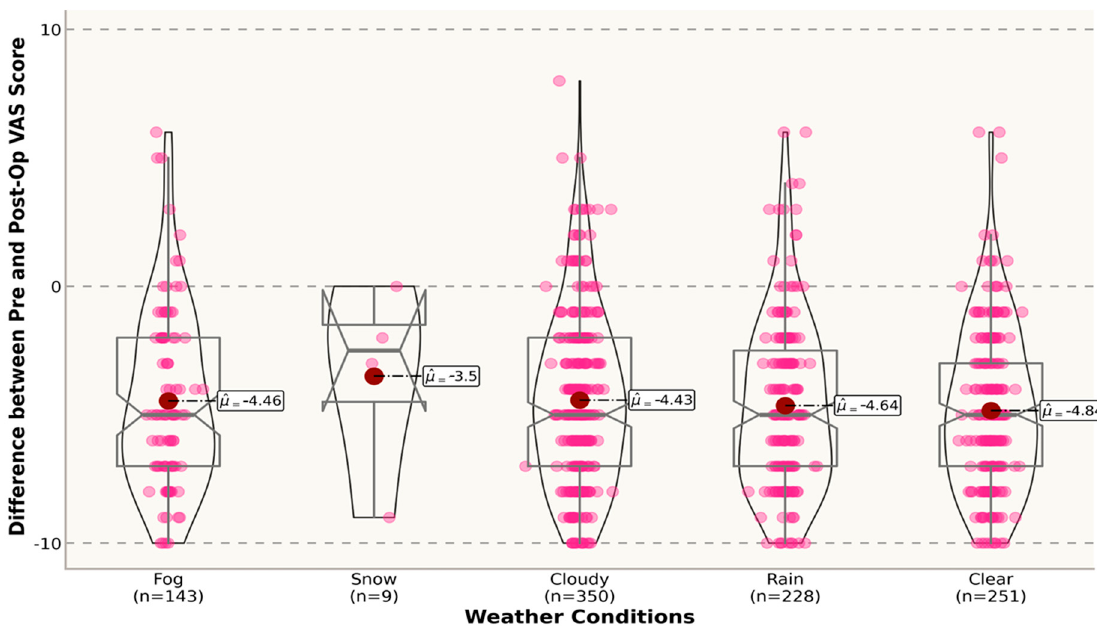
Figure 5. Differences between pre- and post-op scores in different weather conditions (6 months).